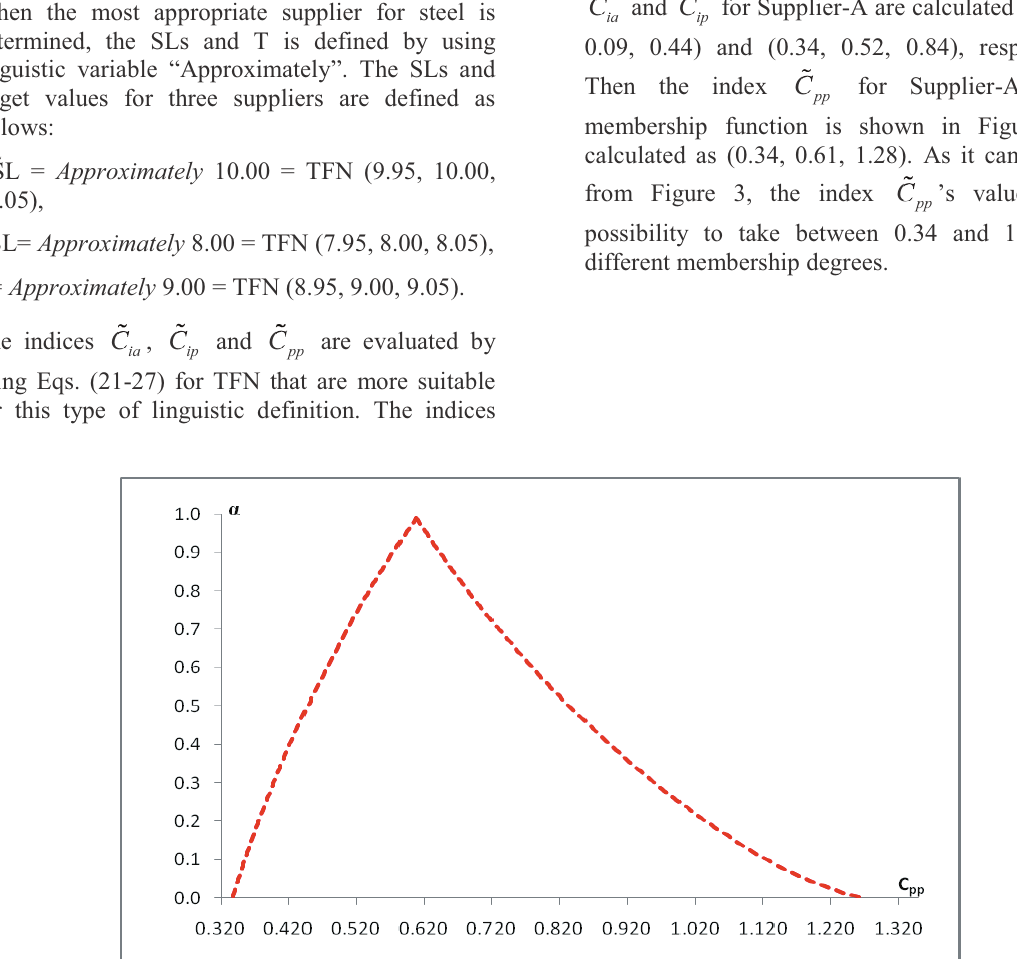
Figure 3 Membership function the index for